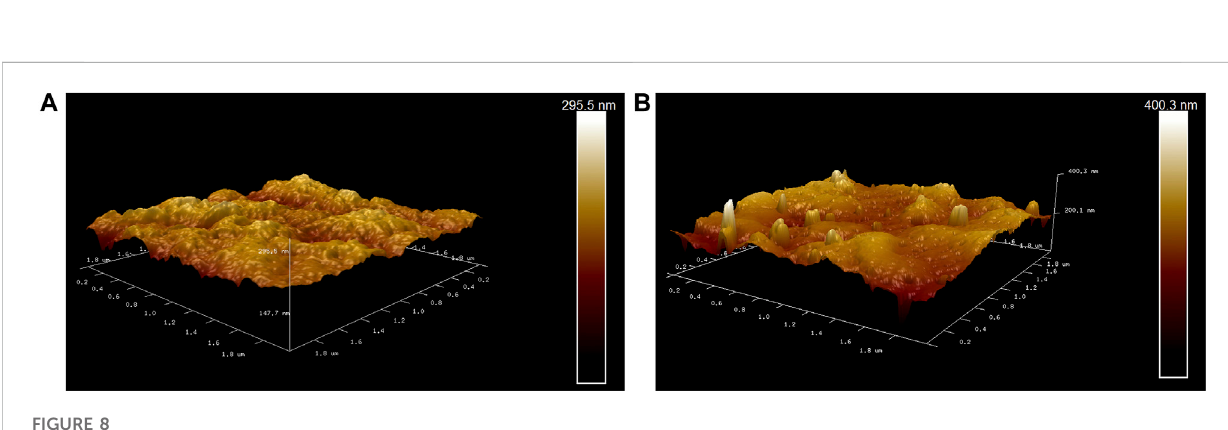
FIGURE 8 AFM images: (A) PVDF membrane and (B) PVDF/DA